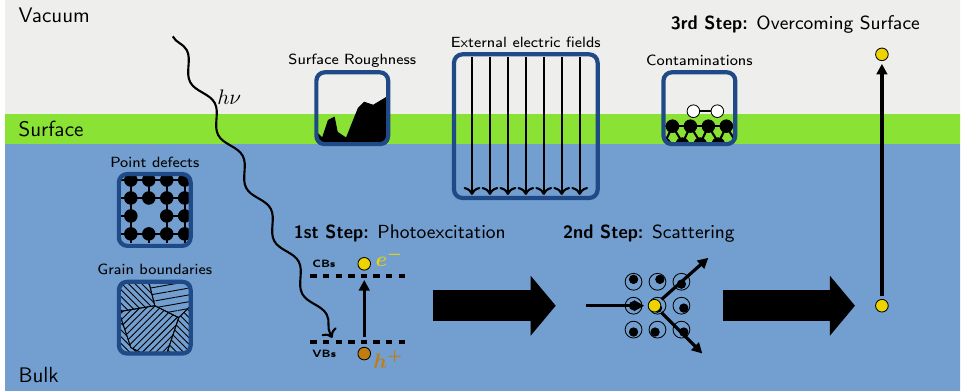
Figure 1. Schematic overview of the main processes involved in Quantum-Mechanical modeling of semiconducting photocathode materials from first principles. The main physical mechanisms in the bulk ( bottom , blue) on the surface ( middle , green), and in vacuo ( top , light grey) are sketched in the boxes. On top of these illustrations, the three steps of photoemission are also